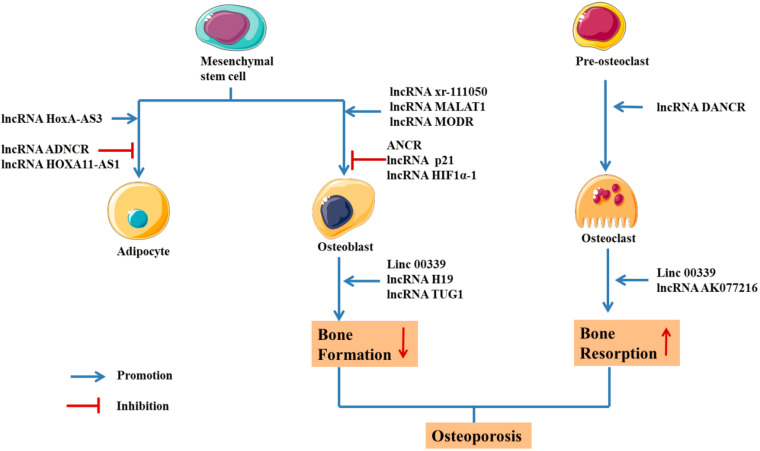
Schematic drawing of functional lncRNAs implicated in osteoporosis (Keniry et al., 2012; Zhu and Xu, 2013; Chan et al., 2014; Che et al., 2015; Tong et al., 2015; Xiao et al., 2015; Xu et al., 2015; Huang et al., 2016; Liang et al., 2016; Zhu et al., 2016; Chen et al., 2017; Wang et al., 2017; Wei et al., 2017; Weng et al., 2017; Xia et al., 2017; Zhang et al., 2017; Feng X. et al., 2018; Feng L. et al., 2018; Li H. et al., 2018; Sun X. et al., 2018; Liu et al., 2019; Yang et al., 2019a; Zhu E. et al., 2019; Zhu J. et al., 2019).